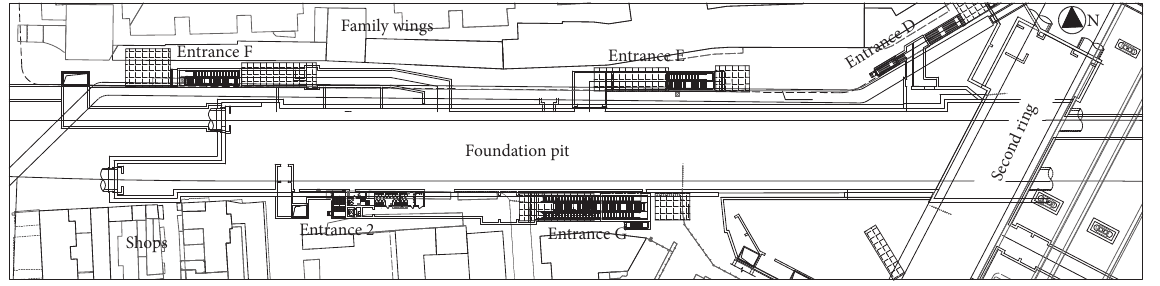
Figure 6: Station location and its surrounding environment. Table 1: Soil properties and its distribution.